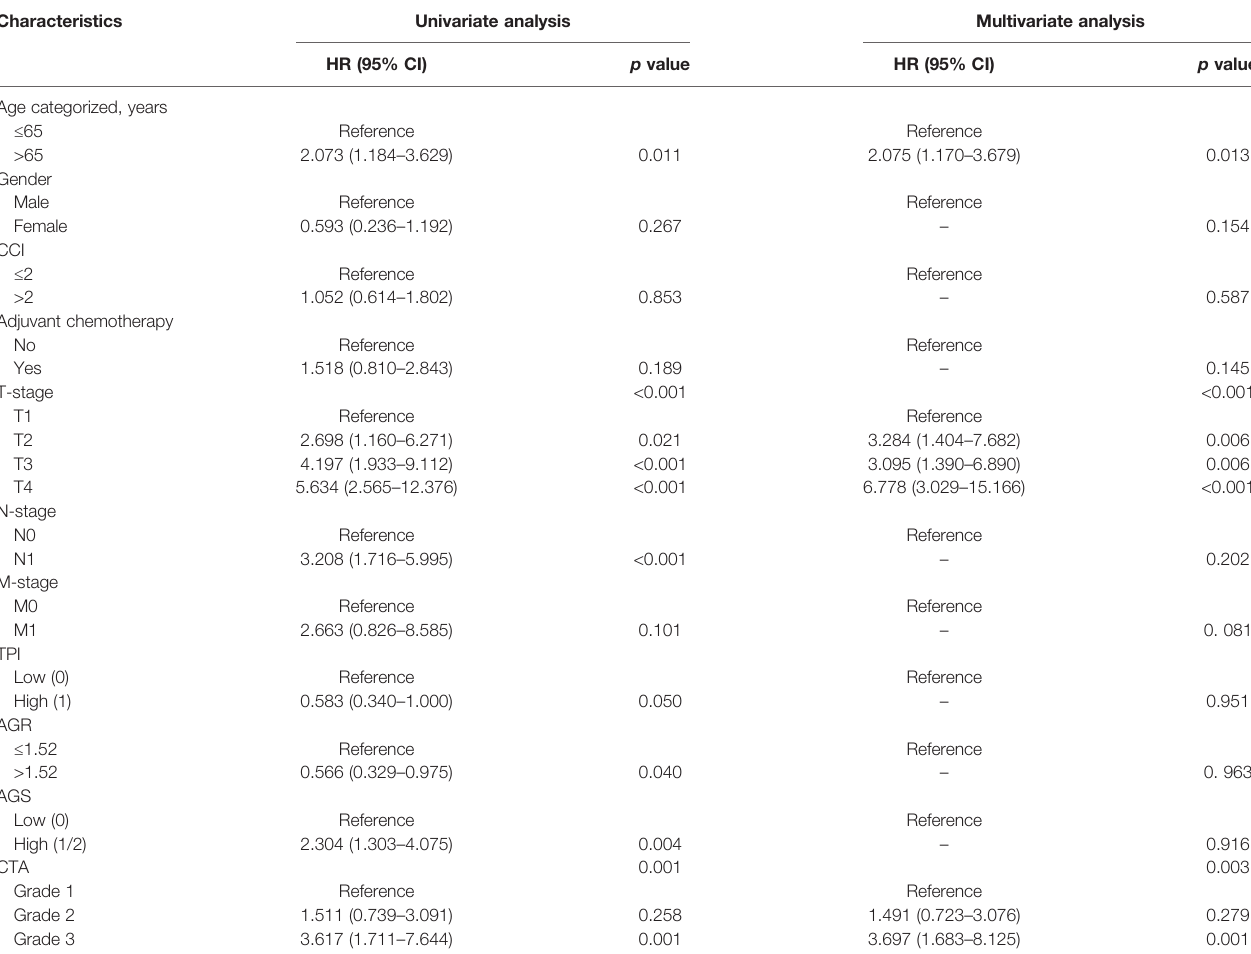
TABLE 5 | Univariate and multivariate analyses of factors associated with overall survival (OS).